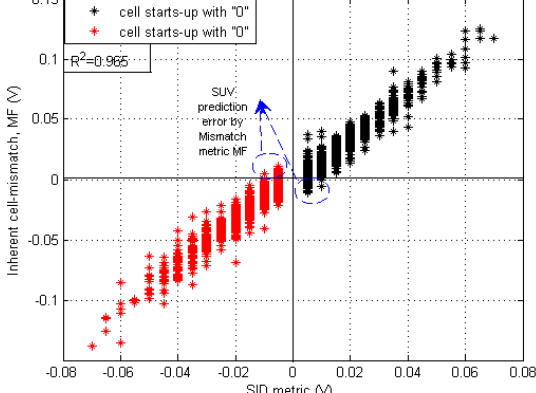
Figure 8. The relationship between the separatrix metric (SID) and mismatch metric, in which the coloring is based on the original SUV set as a reference.